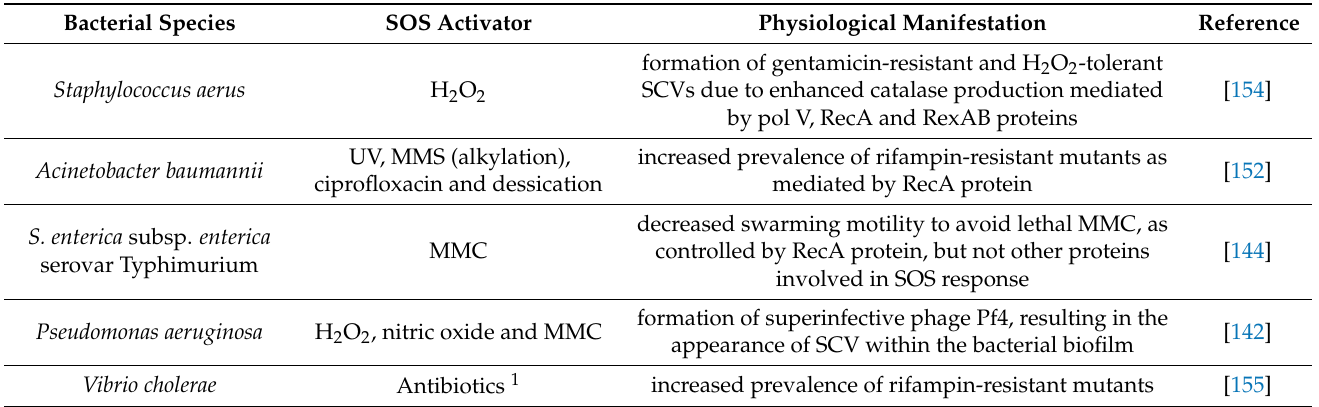
Table 5. Selected studies on sub-lethal SOS-inducing stresses resulting in differential bacterial